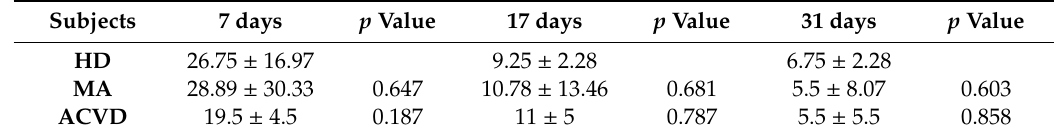
Figure 2. Cultured EPCs from ( A – E ) HD, ( F – J ) MA, and ( K – O ) ACVD representative subjects at 5, 7, 10, 17, and 31 days after seeding in Microvascular Endothelial Cell Growth Medium (EGM-MV medium) (20× magnification, 50 µm scale bar).